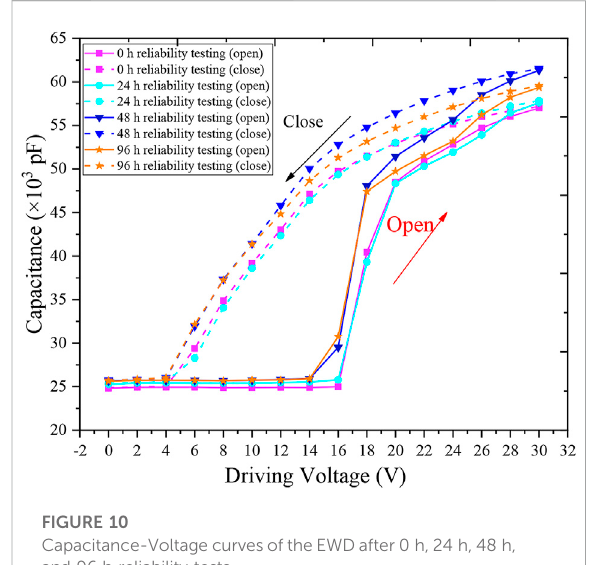
FIGURE 10 Capacitance-Voltage curves of theEWDafter 0 h, 24 h, 48 h, and 96 h reliability